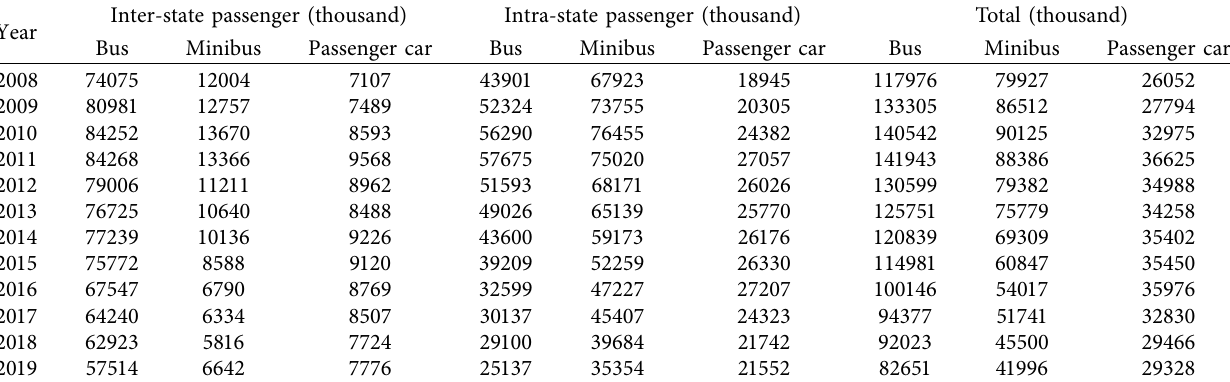
Table 1: Number of public Rural Road Passengers in Terms of Vehicle Type from 2008 to 2019 (Statistical yearbooks of road transport from 2008 to 2019)